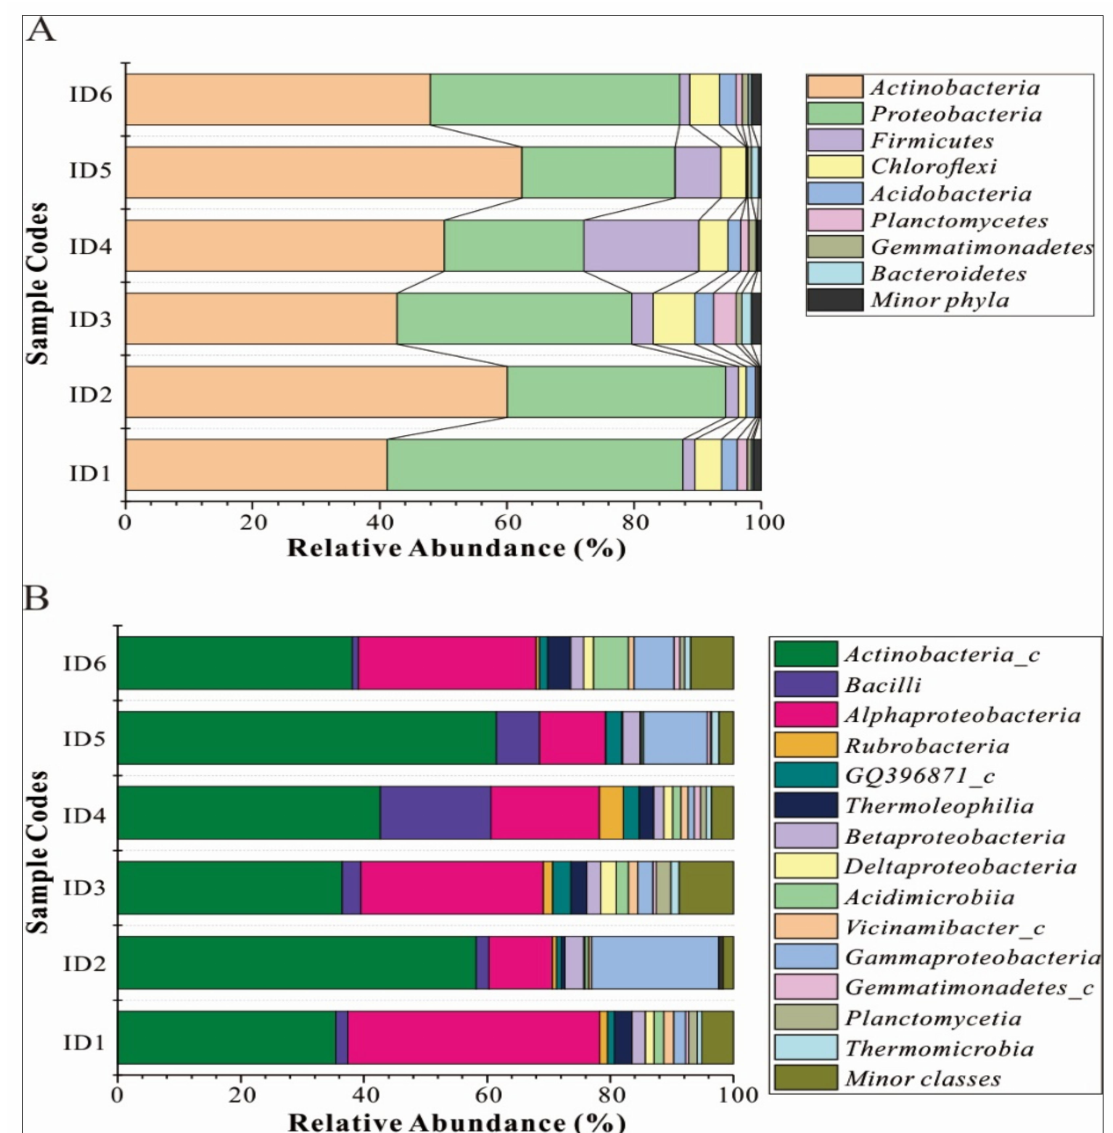
Figure 1. Relative abundance of the bacterial phyla ( A ) and classes ( B ) present in the various illegal dumping